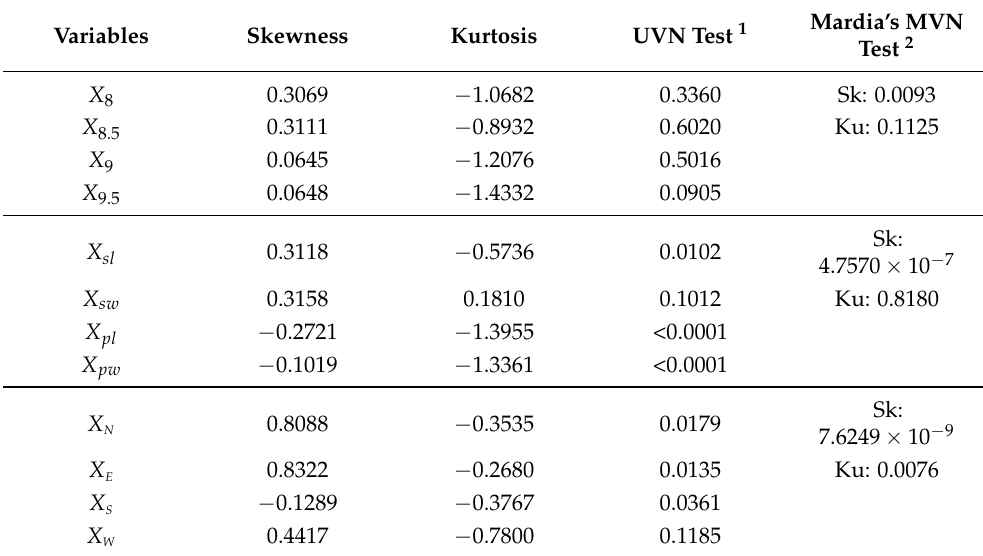
Table 3. Skewness and Kurtosis for each measurement and feature.